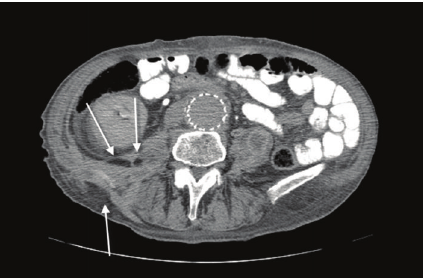
Figure 2: A stent-graft infection with abscess within the psoas mus- cle and skin fistula.